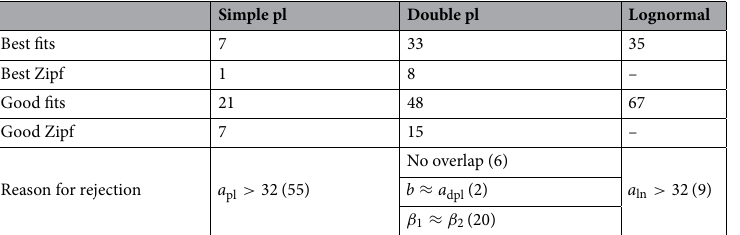
Table 3. Summary of the fits for the 76 composers. First row counts distributions yielding the best fits (in terms of fitting more data); Second row counts the Zipf subcases among the best fits (exponents β and β 2 between 1.8 and 2.2); third counts distributions yielding good fits (fit not rejected but not necessarily the best); and fourth counts the Zipf subcases among the good fits. The statistics for the reason of rejection (bad fits) are also included (in